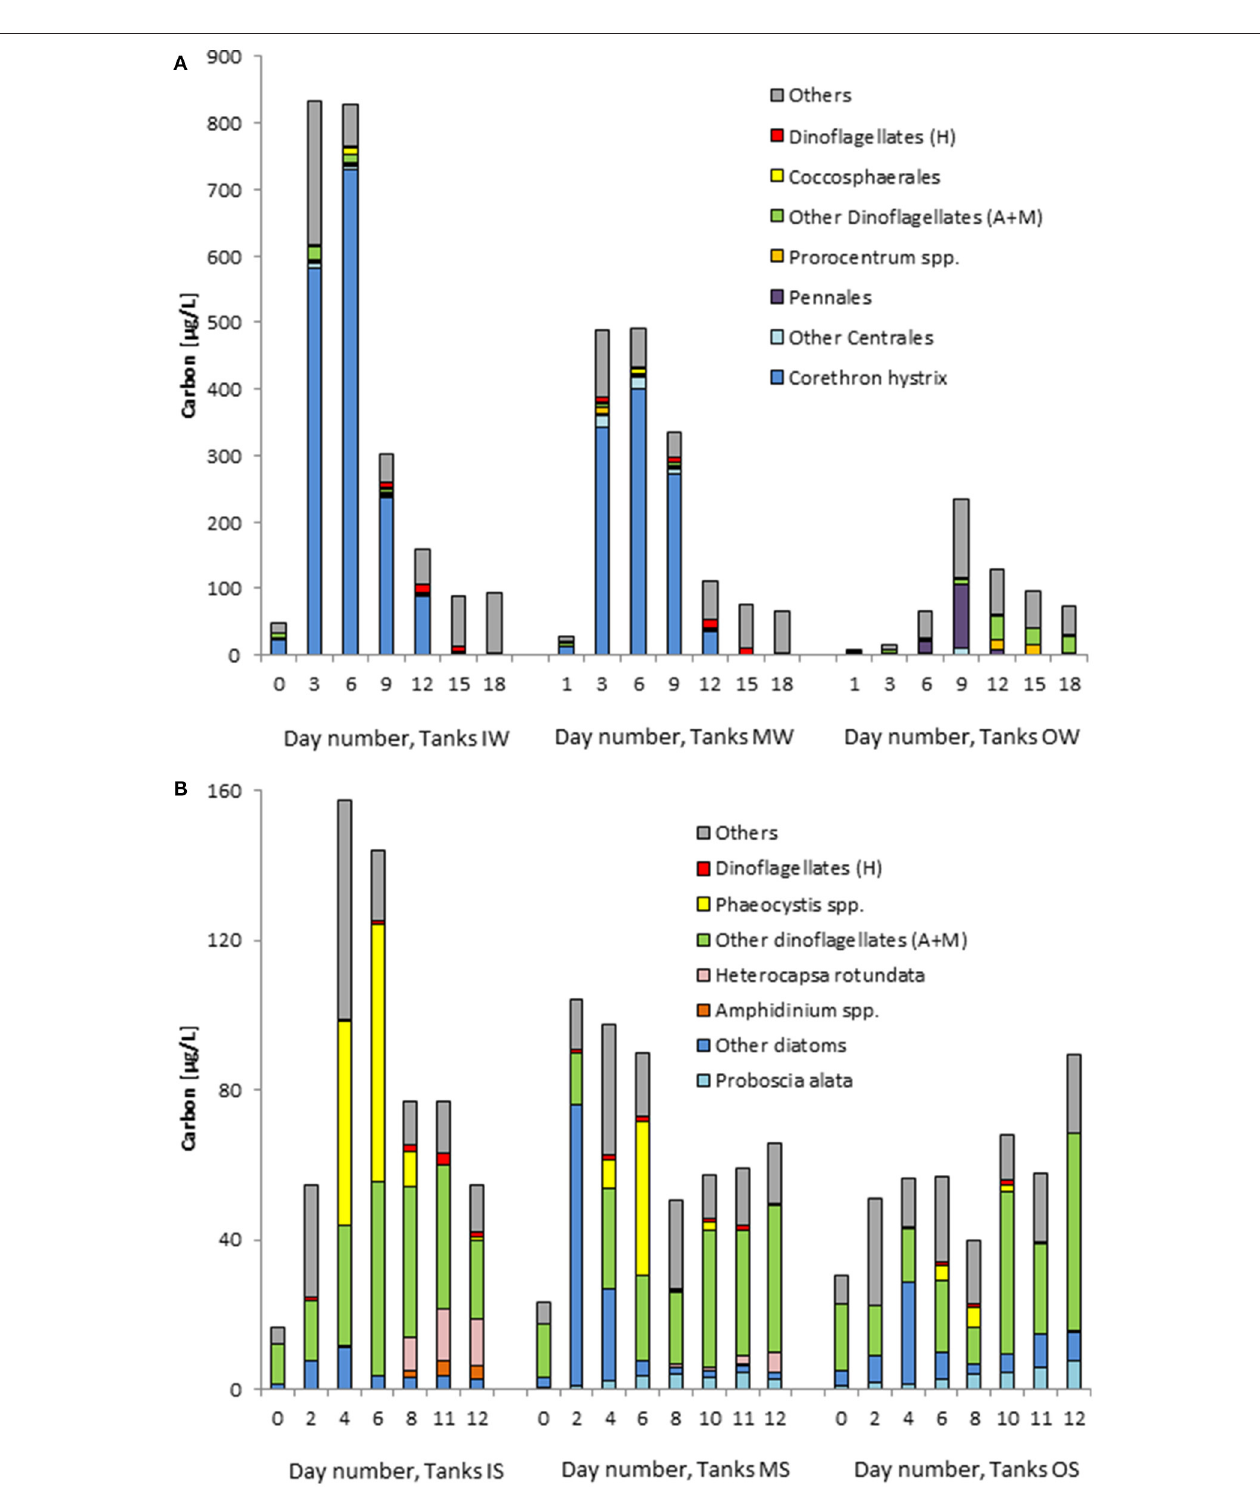
FIGURE 12 | Development of the biomass (wet weight) of the most important phytoplankton taxa in the tanks containing water from “inside” (IS) and “outside” (OS) the filament and mixed water (MS), on cruise M100 (A) and on cruise M103 (B). Dinoflagellates are split into an autotrophic + mixotrophic (A + M) and a heterotrophic (H) group. Mean values of the three replicate tanks are shown.